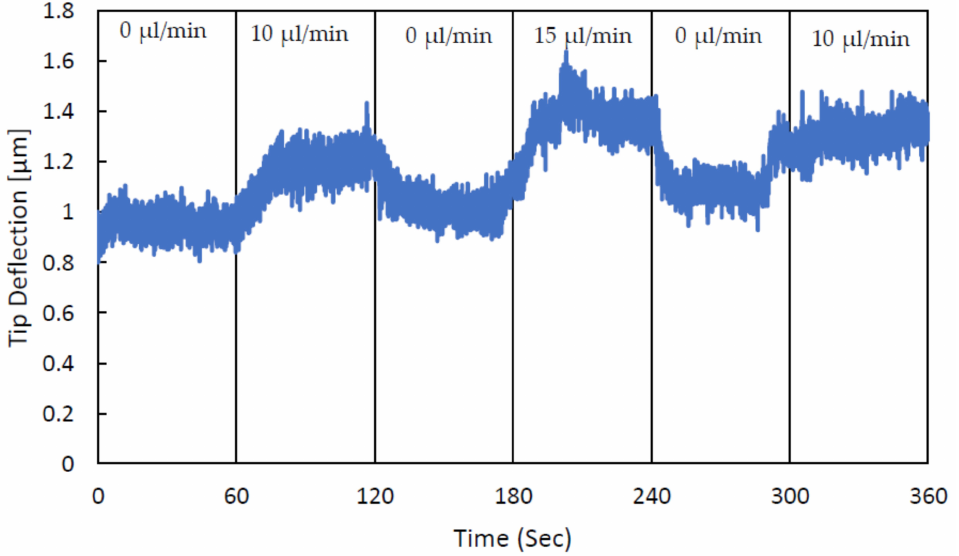
Figure 13. Sensitivity experiment of 3D suspended microcantilever, which has a 200 × 100 µ m 2 (width and depth) channel with various step flows of 0-10-0-15-0-10 µ L/min. The syringe pump flow rate changes every 60 s, and SPMF 3 responds to this new flow